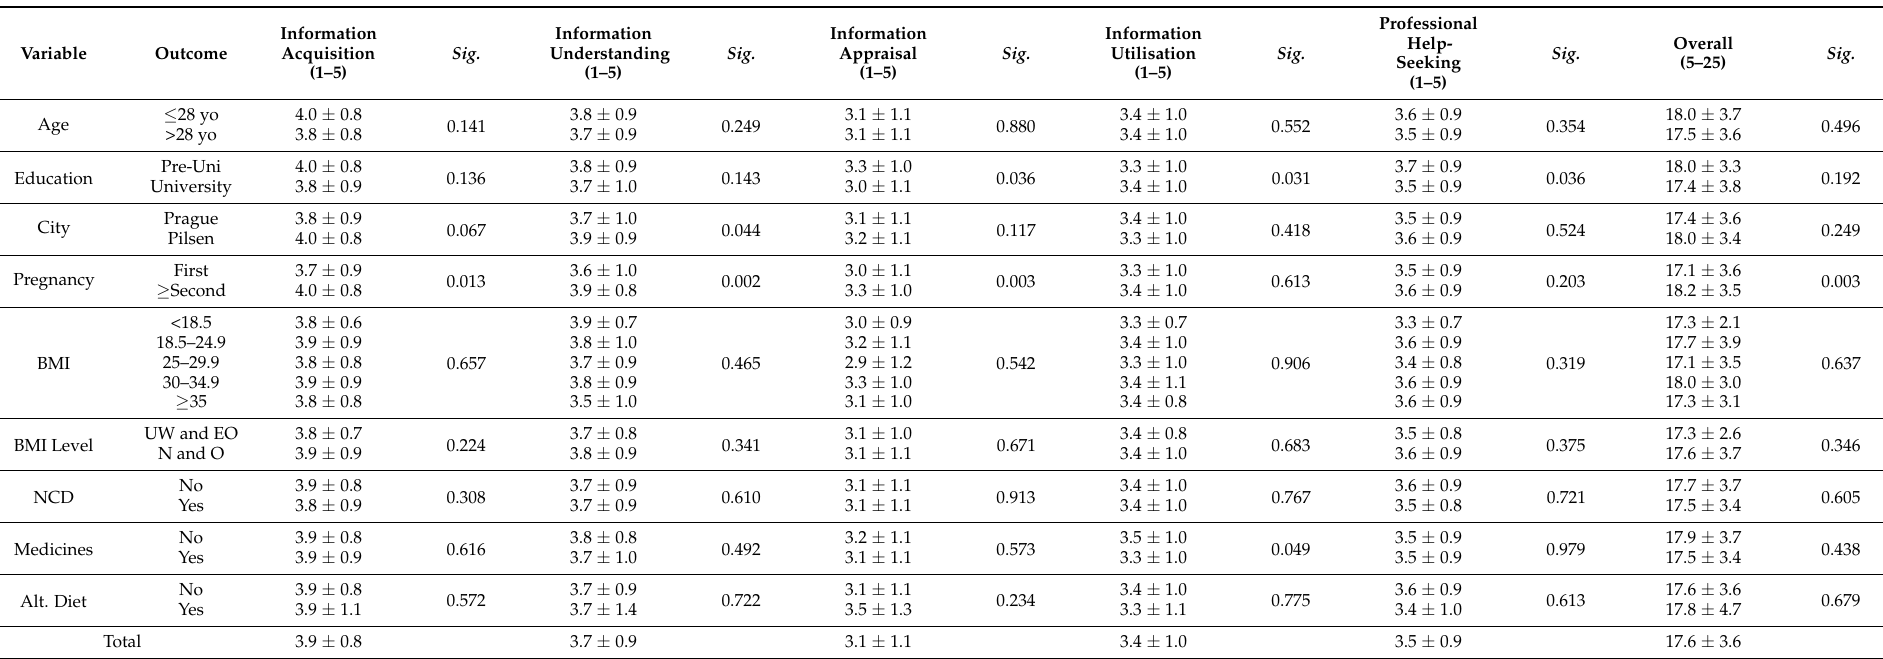
Table 7. Nutritional health literacy scores of pregnant women participating in the nutritional health survey, April–May 2022 ( n =